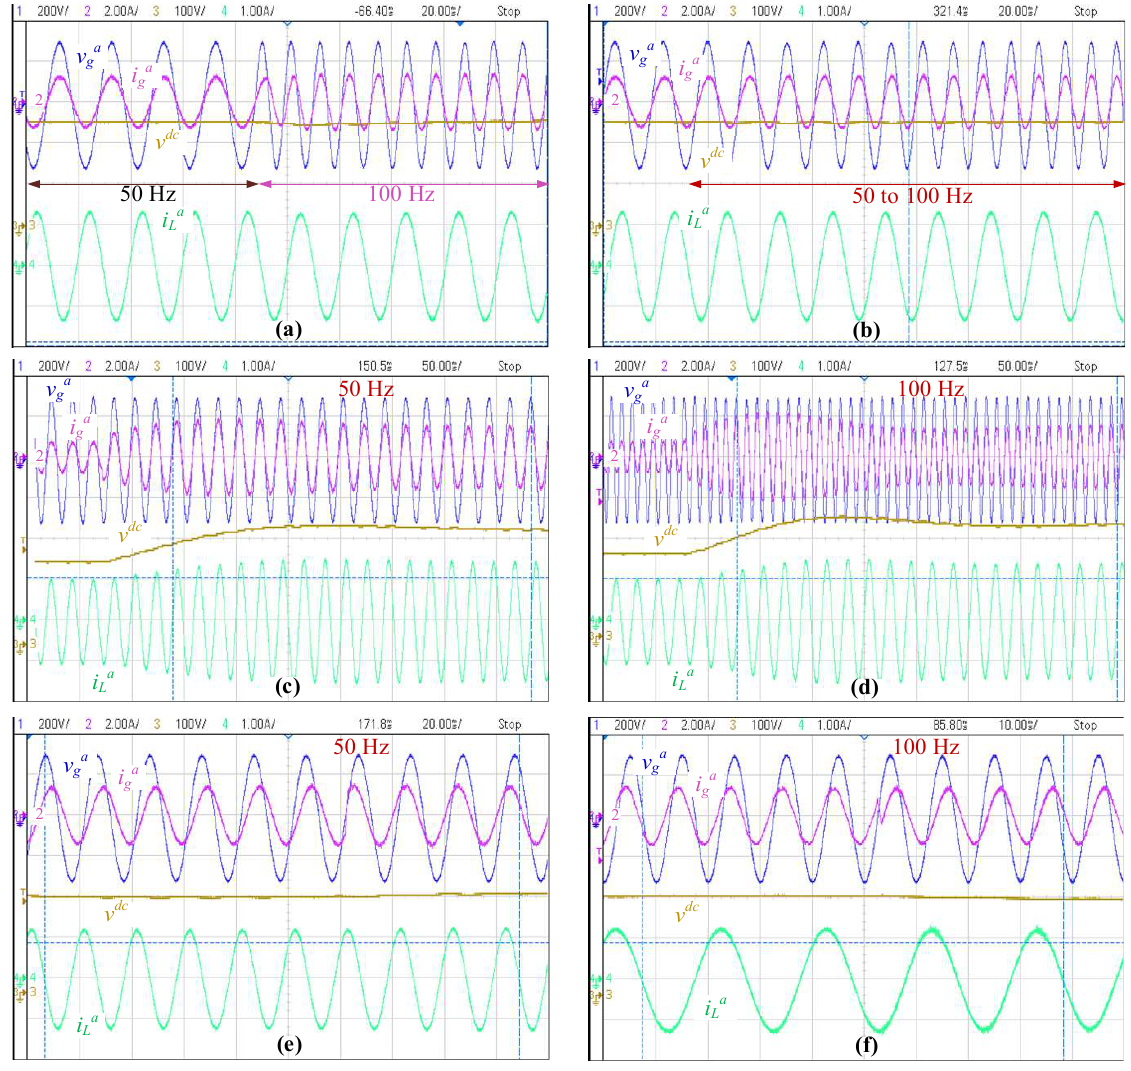
Figure 10. Results for dynamic decoupler; ( a ) step-up frequency change; ( b ) ramp-up frequency change; ( c ) dc voltage step-up response with f g = 50 Hz; ( d ) dc voltage step-up response with f g = 100 Hz; ( e ) power factor step response with f g = 50 Hz; ( f ) power factor step response with f g = 100 Hz.